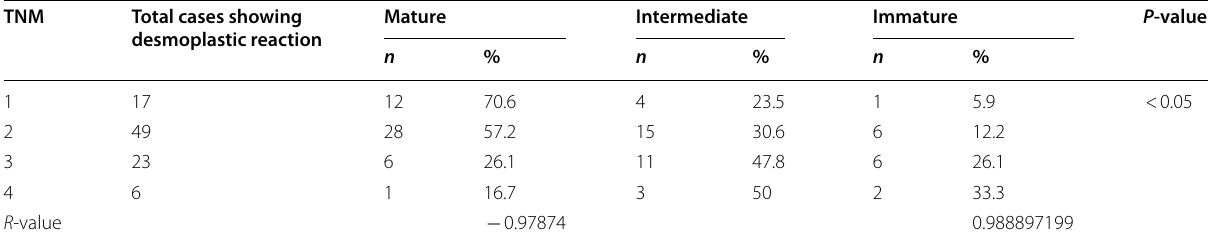
Table 2 Association between tumor stage (as per AJCC) and type of stromal desmoplastic reaction